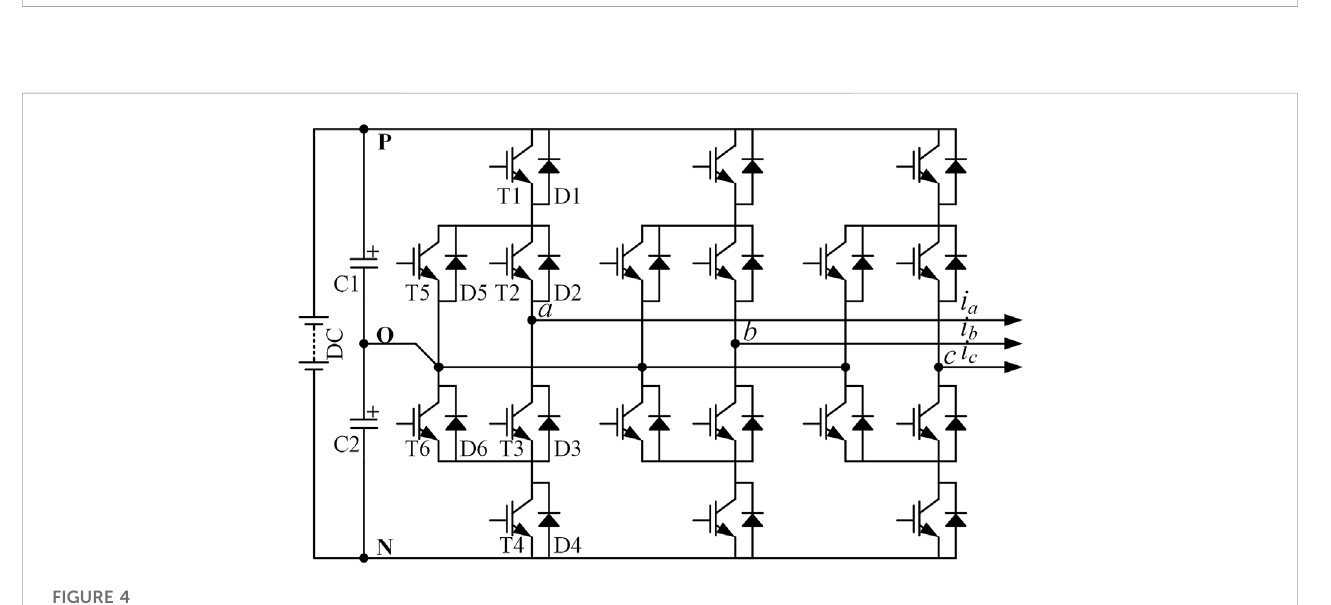
Topology of a 3L-ANPC